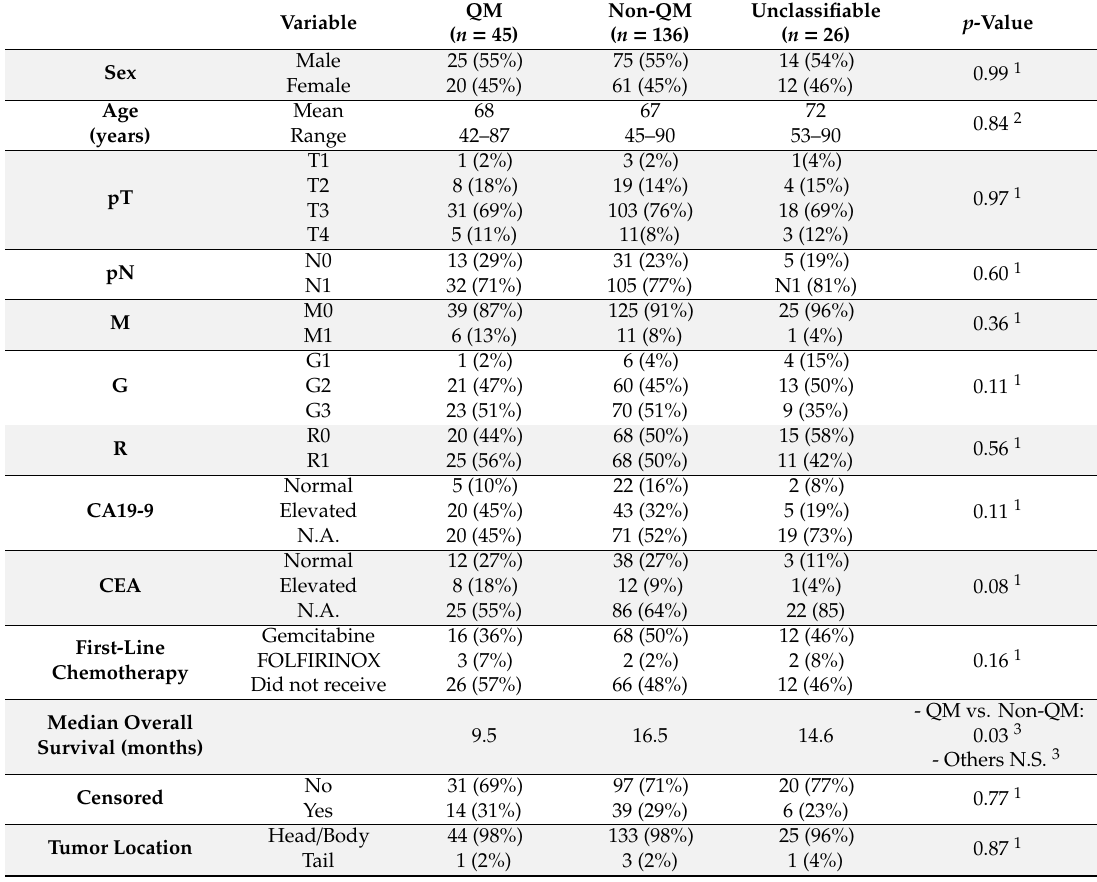
Table 1. Clinical parameters and cross-tabulation results for the QM, non-QM and unclassifiable cohorts. Abbreviations: pT: tumor T-stage, pN: nodal status, M: metastasis, G: